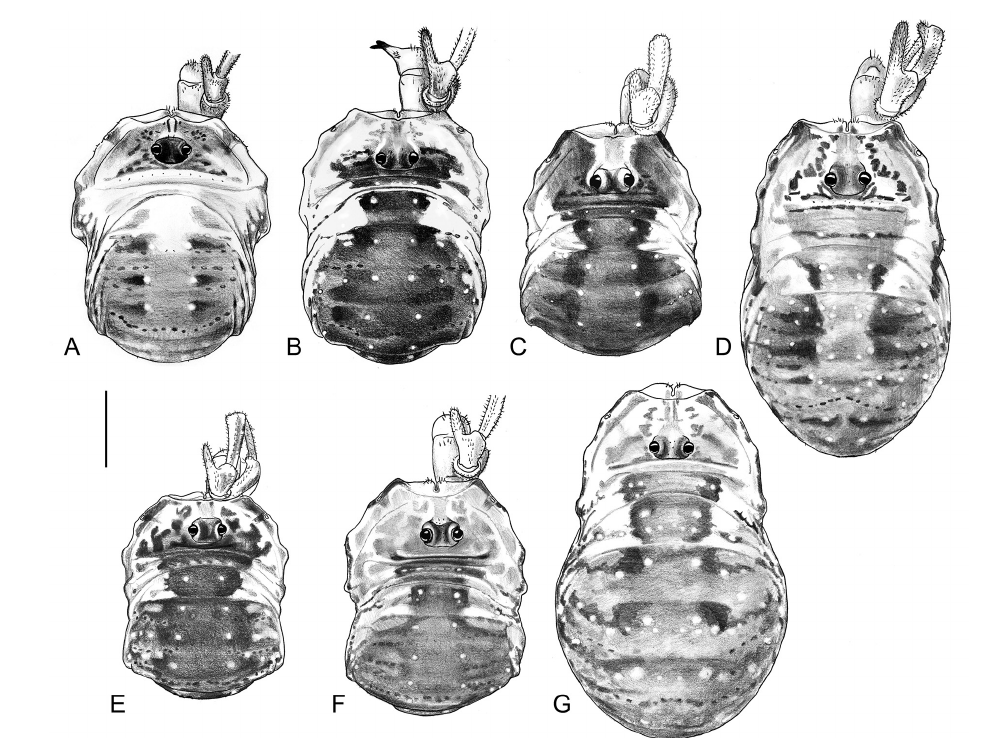
Fig. 4. Dorsal colour pattern of species of Dicranopalpus Doleschall, 1852, ♂ (A–C, E–F) and ♀ (D, G). A . D. insignipalpis (Simon, 1879) (CJM 7258). B . D. cantabricus Dresco, 1953 (ZUPV 4542). C – D . D. gallaecicus sp. nov. (CHW 491). E . D. pyrenaeus Dresco, 1948 (CJM 2649). F – G . D. catariegensis sp. nov. (F: CHW 469; G: paratype, CJM 9005). Scale bar = 1.0 mm.